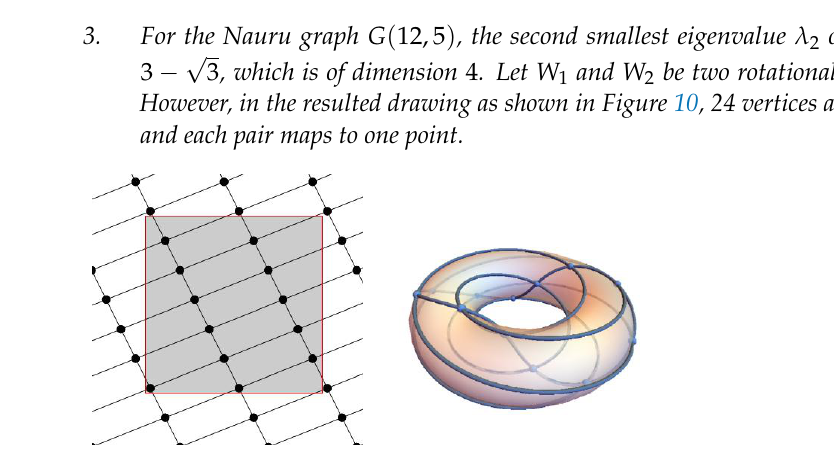
Figure 10. The (ramified) drawings of the Nauru graph G ( 12,5 ) .